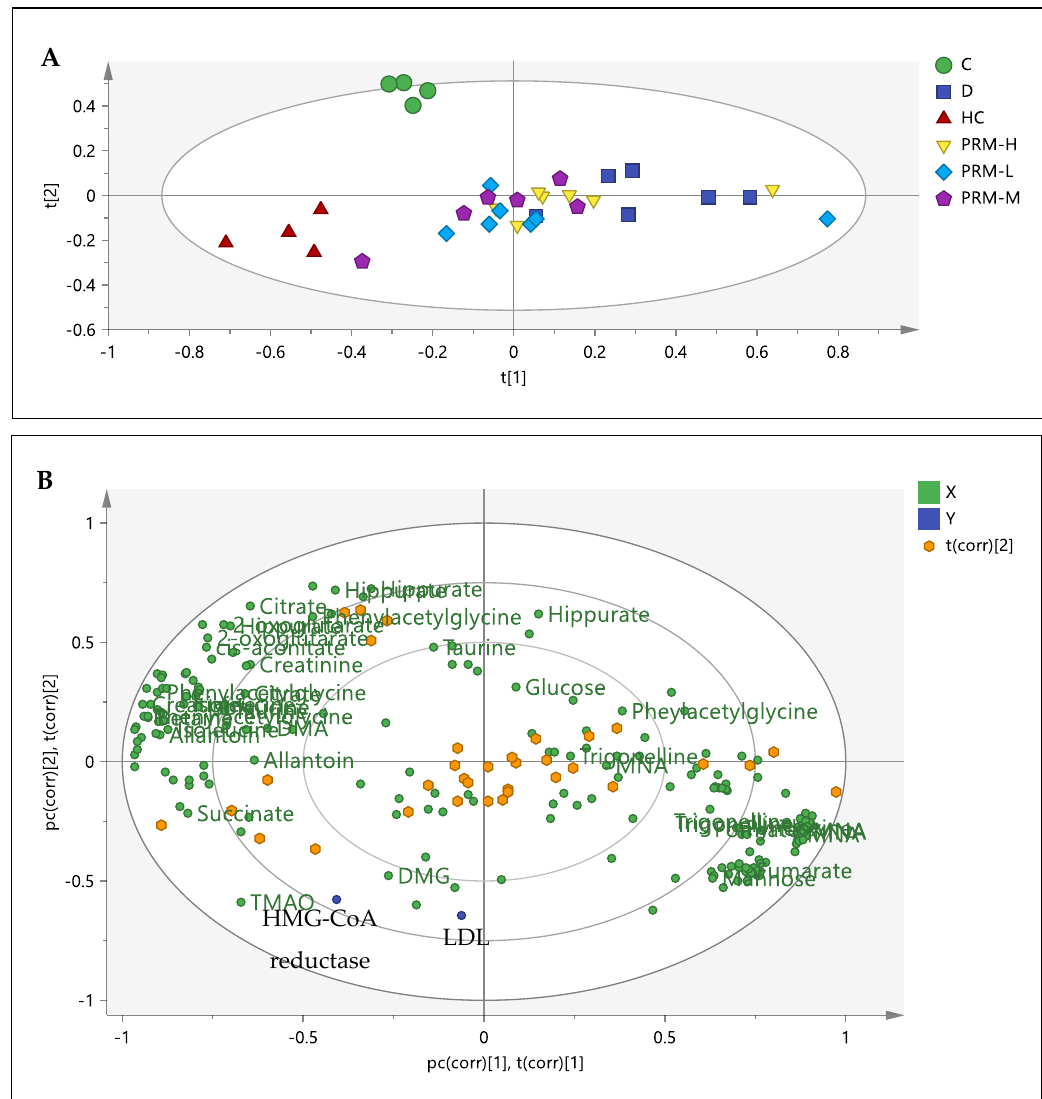
Figure 2. Partial least square (PLS) M3. Score plot ( A ) and biplot ( B ) obtained using 1 H-NMR from control (C), simvastatin